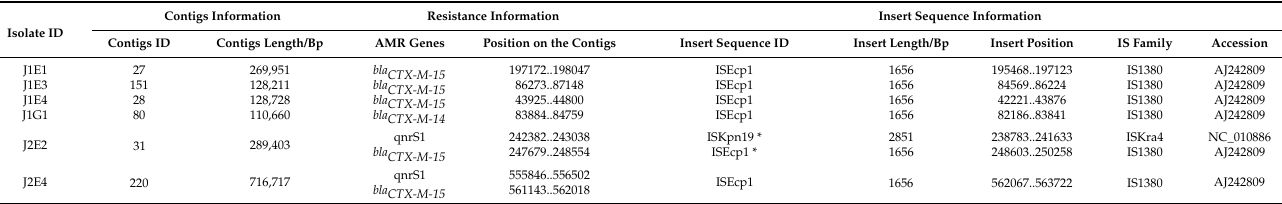
Table 4. Insert sequence and their location detected by